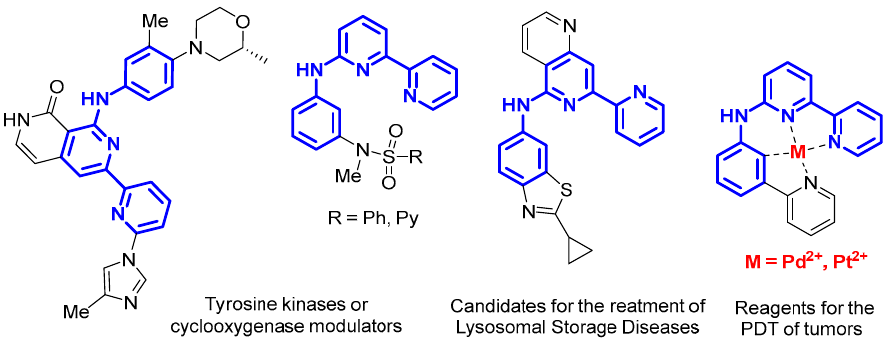
Figure 1. Examples of biologically active α -arylamino-2,2 ′ -bipyridines [2,4,5,12].